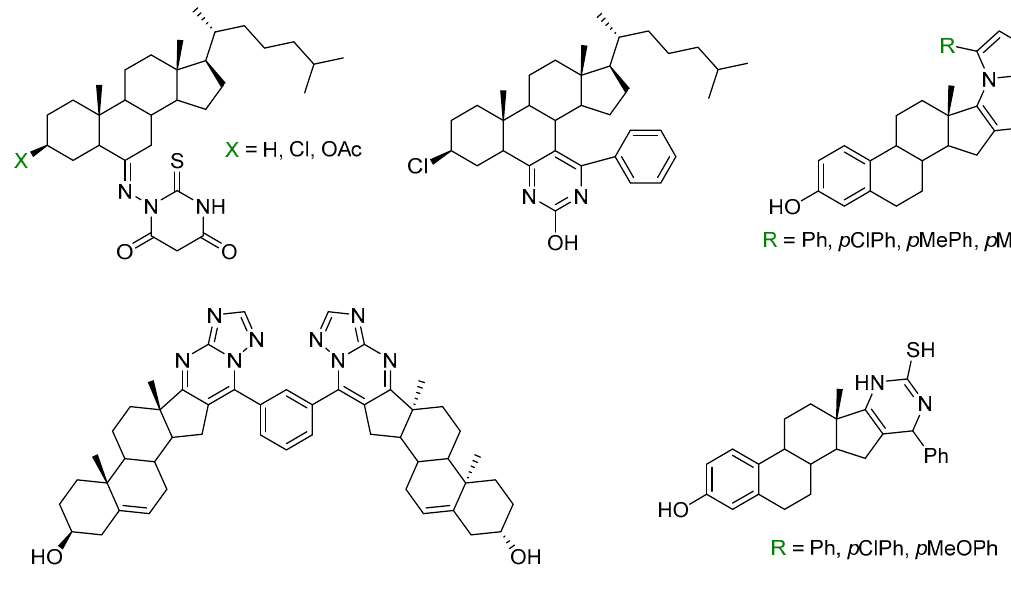
Figure 1. Illustrative biologically active steroidal pyrimidines.